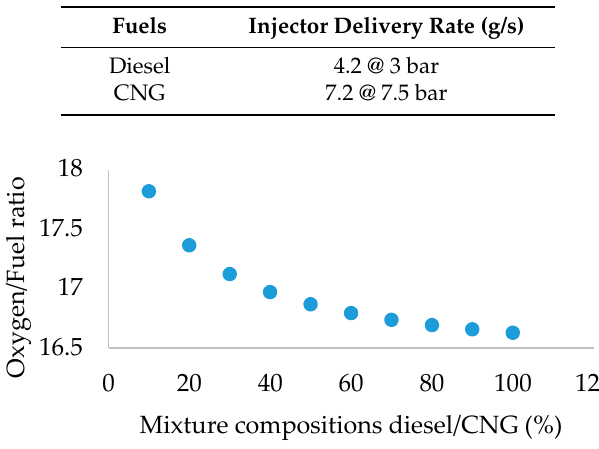
Figure 2. Lambda for various mixture compositions.